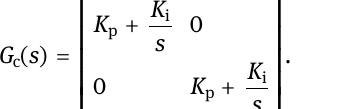
Table 1: Speci fi cation of the system parameter